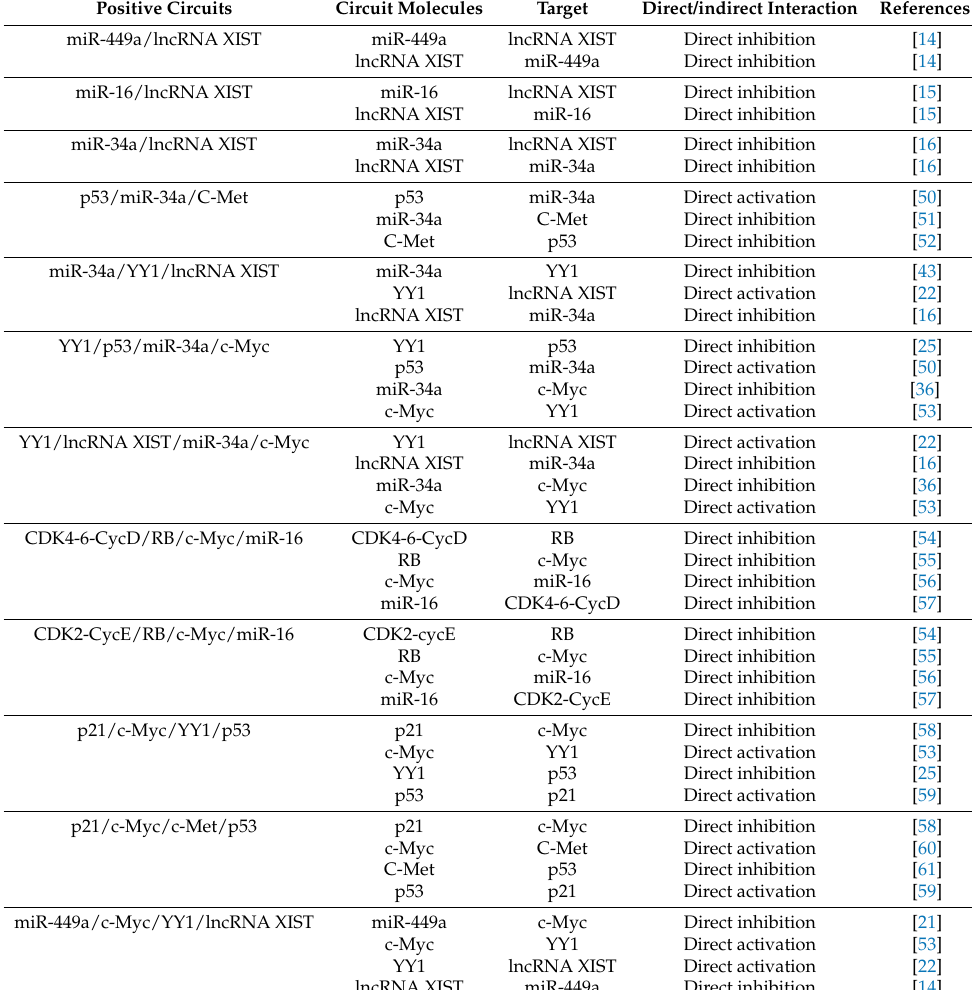
Table 3. The evidence of the biochemical interactions defining the positive circuits is well-characterized in the literature.